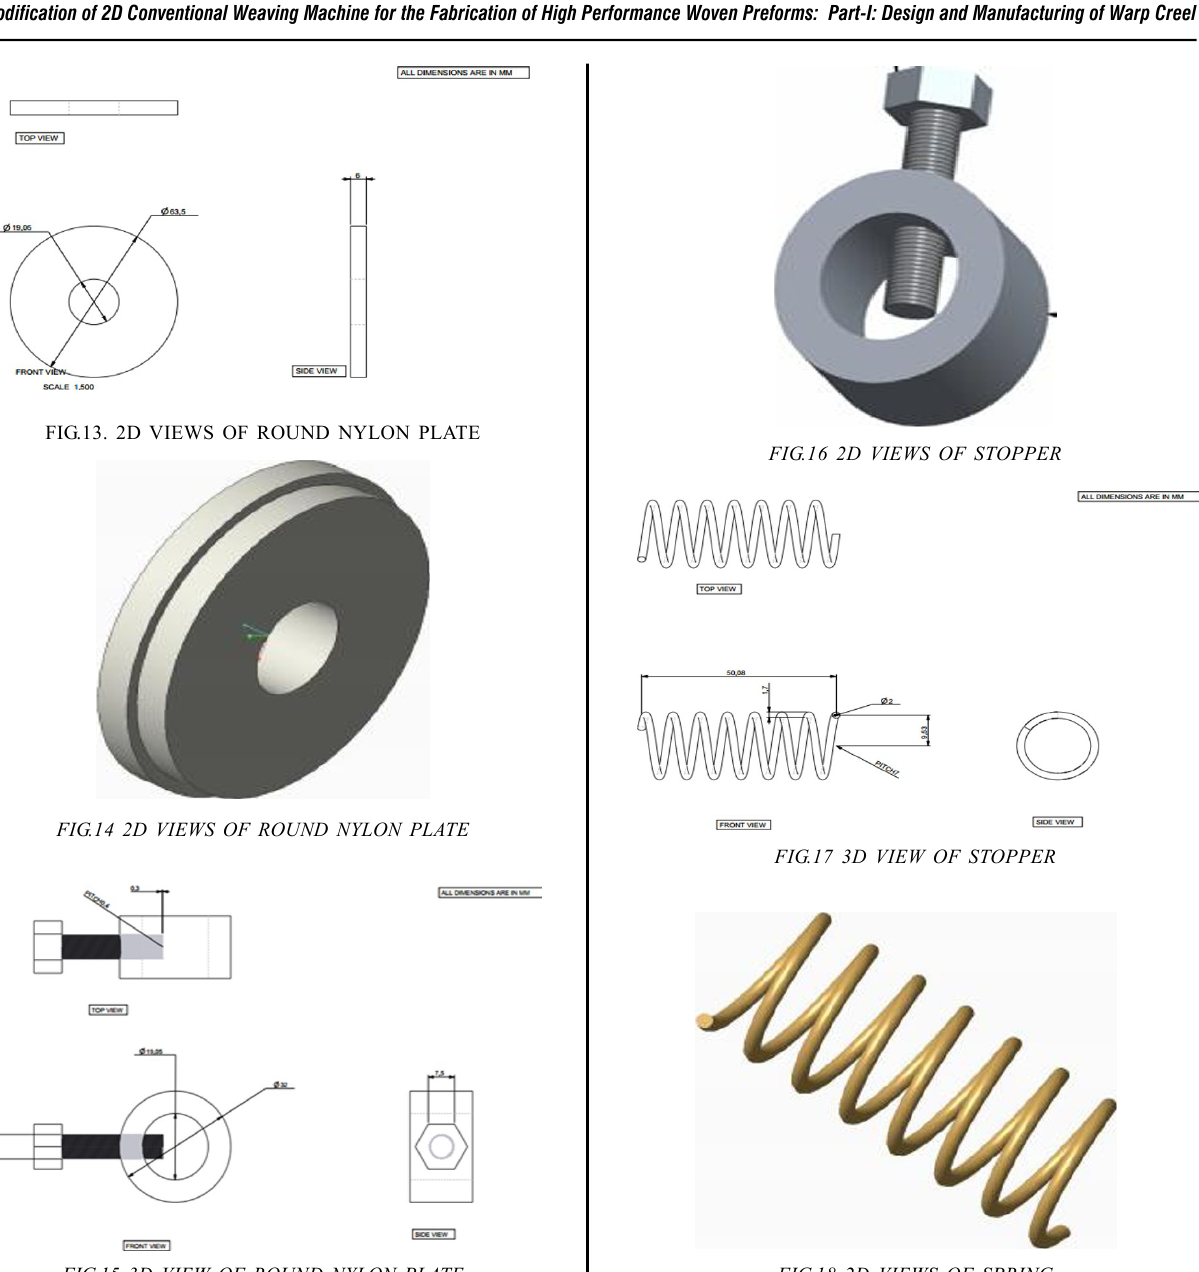
FIG.15 3D VIEW OF ROUND NYLON PLATE